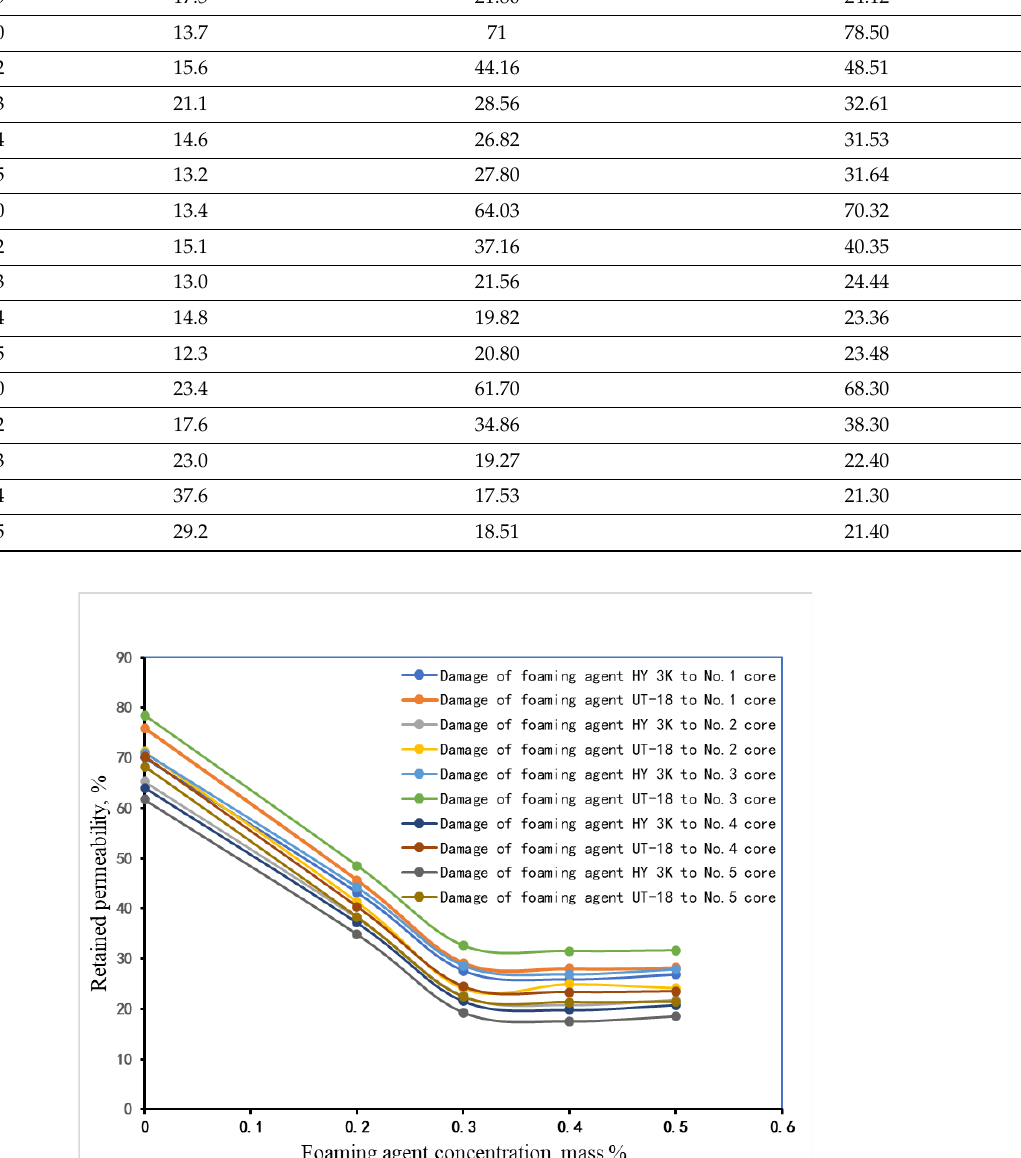
( a ) ( b ) Figure 4. Contact angle for core 3 before ( a ) and after ( b ) exposure to the foaming agent solution prepared using agent HY-3K (mass concentration 0.4%). 4. Damage Characteristics of Foaming Agent Solution to Shale Reservoir 4.1. Experimental Procedure Permeability damage was quantified using results of the filtration experiments. The filtration experiments were performed using core samples 25 mm in diameter and 45 mm